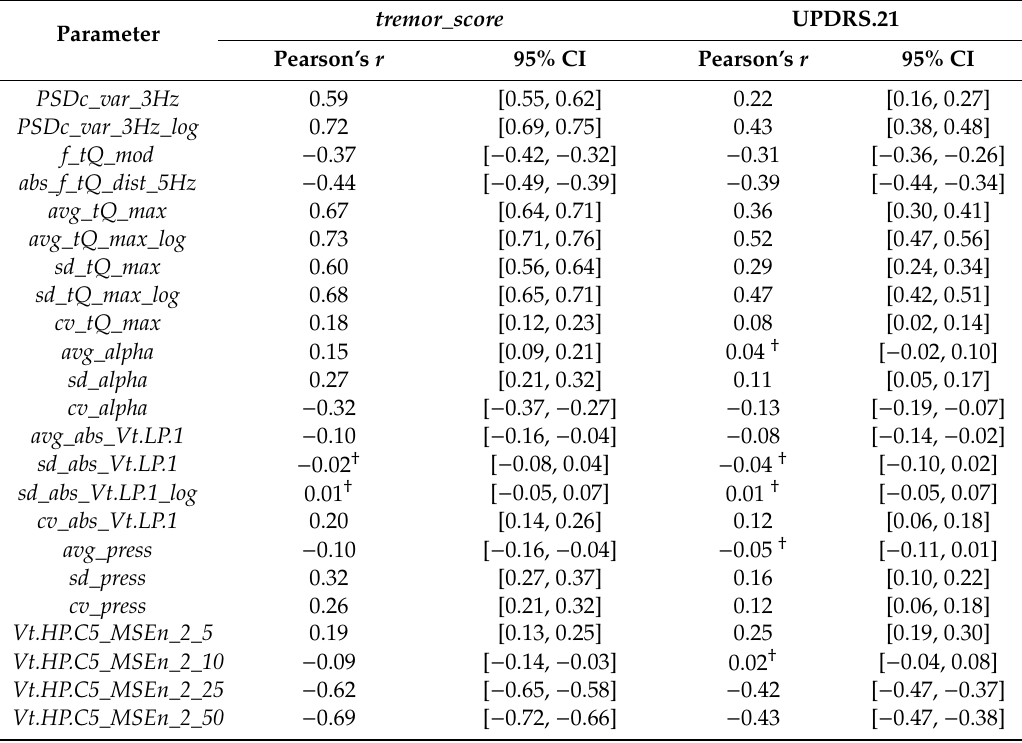
Table 3. Pearson’s correlation coe ffi cients between the signal-based parameters and the target scales. tremor_score UPDRS.21 Parameter Pearson’s r 95% CI Pearson’s r 95%